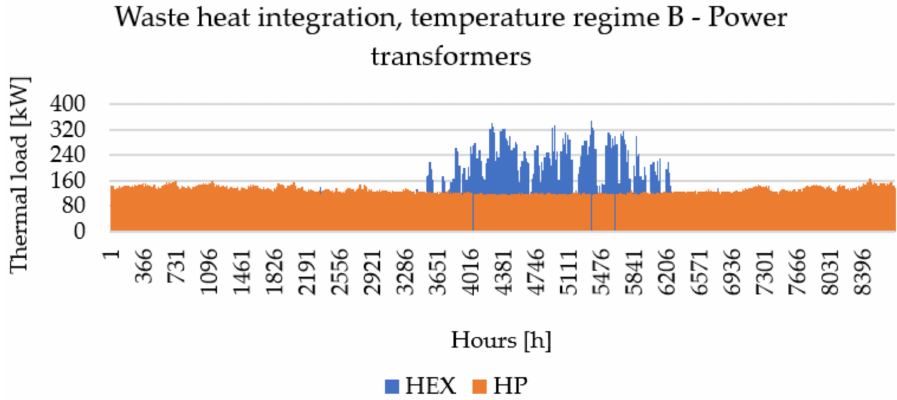
Figure A7. Waste heat utilization per technology, DH temperature regime B—power transformers.